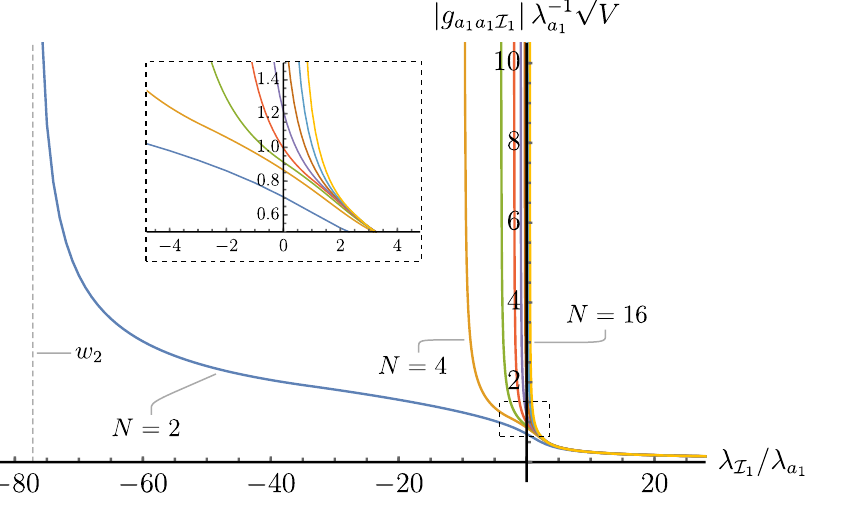
p j (cid:21) (cid:0) 1 V as we vary (cid:21) a a 1 1 a 1 I 1 =(cid:21) a = 4 correspond to modes on long (cid:13)at N -tori. 2 1